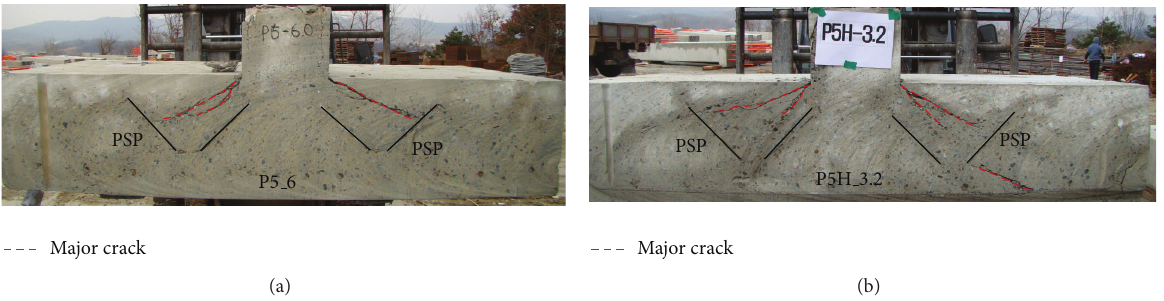
Figure 8: Crack pattern in the middle plane of the test specimen: (a) P5 6 and (b) P5H 3.2.